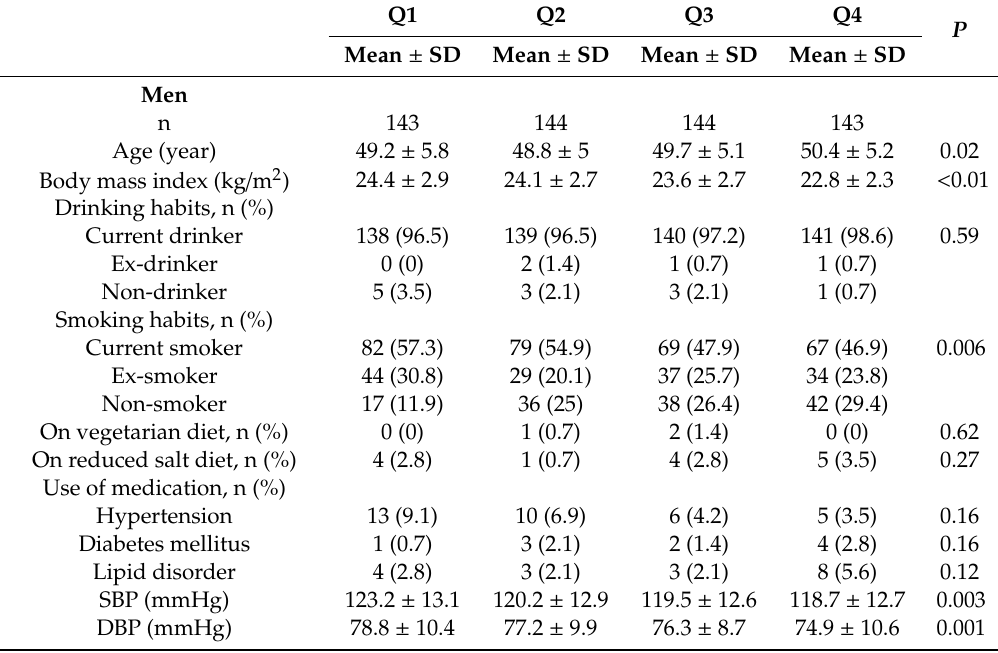
Table 2. Characteristics of participants stratified by quartiles of 24-hr urinary potassium (K) excretion per unit of body weight (mmoL / 24 hr / kg, UK / BW), men and women, ages